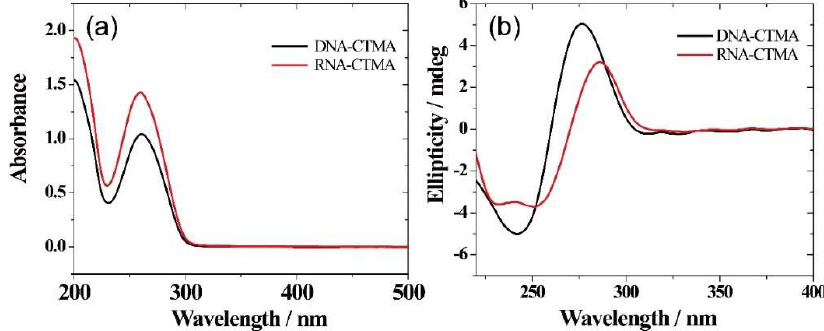
Figure 2. ( a ) UV spectra of the RNA–CTMA complex. ( b ) CD spectra of the RNA–CTMA complex.